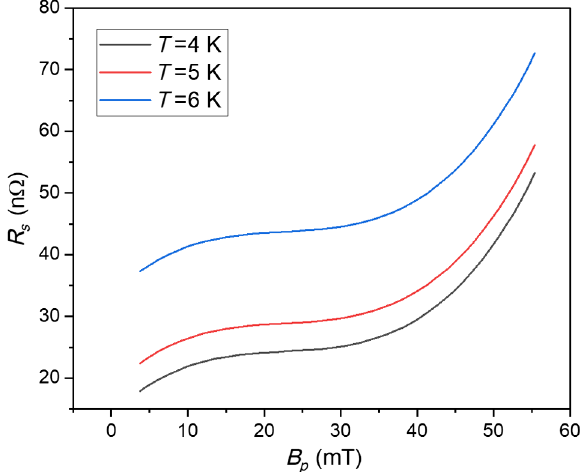
FIG. 5. Temperature distribution for the cavity with ∼ 1 MW of ¼ 47 rf input power and operating at B p